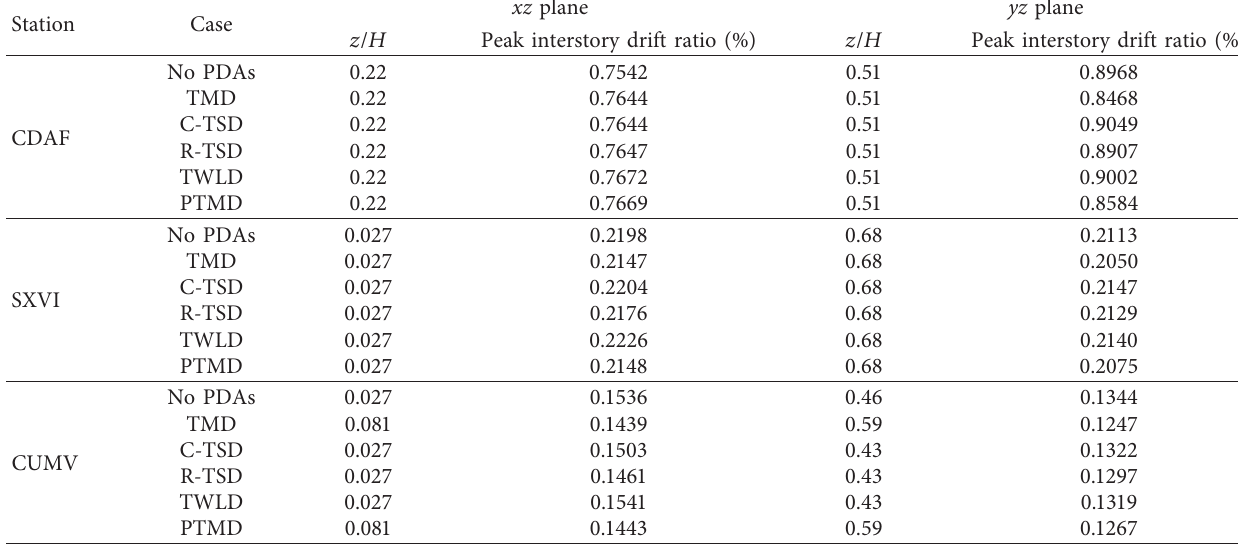
Table 18: Peak interstory drift ratio at the critical story.